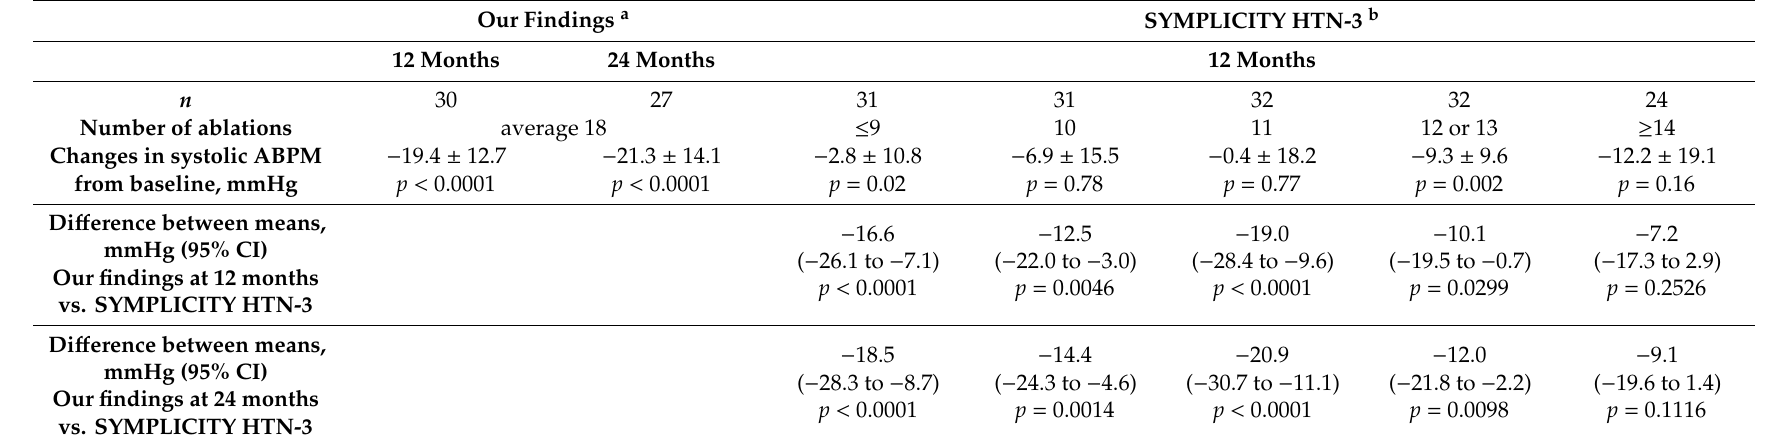
Table 3. Number of ablated spots in renal arteries and changes in systolic ABPM after renal